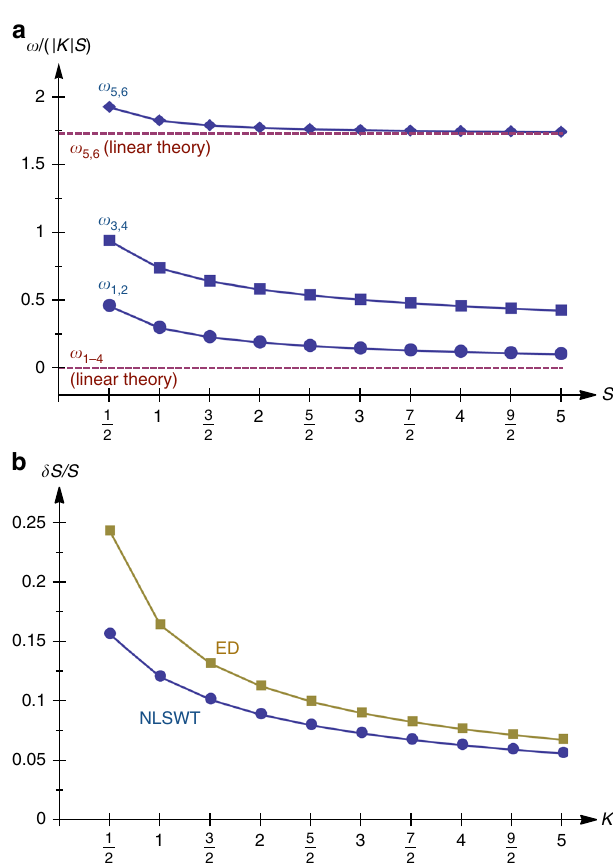
Fig. 6 Spin-wave modes and relative spin-length correction. a Magnon frequencies ω 1 – ω 6 (in units of K j j S ) from linear (dashed) 16 and non-linear spin-wave theory (solid), above the classical states associated with the dimer pattern of Fig. 2a, inside the uniform fl ux sector B h Relative spin length correction δ S / S in the same sector, as extracted from non-linear spin-wave theory (NLSWT, blue circles) and exact diagonalizations (ED, dark yellow squares) of the Hamiltonian H MF